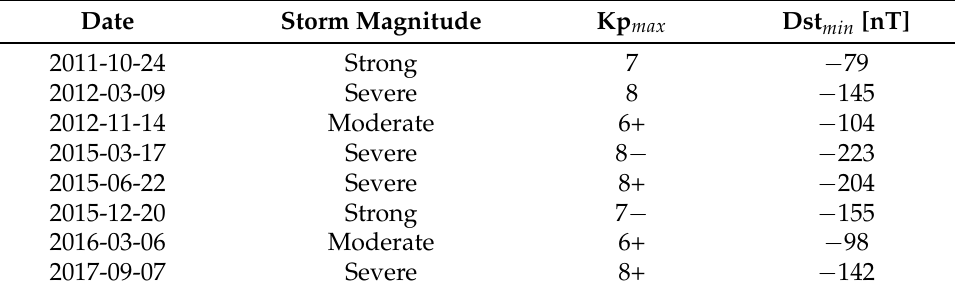
Table 3. Geomagnetic storm classification based on the Dst